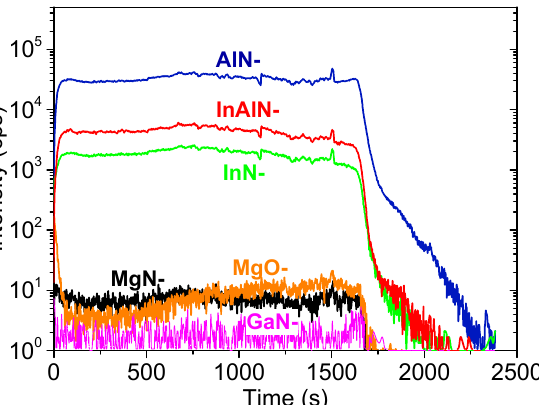
Figure 2. SIMS depth analysis of InAlN grown with 130 nmol/min Cp 2 Mg flow. X-axis refers to sputtering time by profiling. A typical grain mosaic structure [7,20] and a root mean square (RMS) roughness of 5.9 nm were deduced from the 5 × 5 µ m 2 AFM scan of the undoped InAlN, shown in Figure 3a. A number of pits and surface roughness deterioration (RMS ~8.9 nm) appeared with the introduction of CP 2 Mg flow of 30 nmol/min, shown in Figure 3b. Point defects disappeared as the flow was further increased to 80 nmol/min in addition to the enlarge- ment of grains and smoothing of the InAlN surface (RMS ~7.5 nm), shown in Figure 3c. Interestingly, these surface improvements at a CP 2 Mg flow of 80 nmol/min correlated well with a decreased density of screw-type dislocations, shown in Table 1. Finally, the surface detrimentally deteriorated and exhibited a number of misoriented grains at a CP 2 Mg flow of 130 nmol/min (Figure 3d). This partially surprising trend (smoothing of the surface